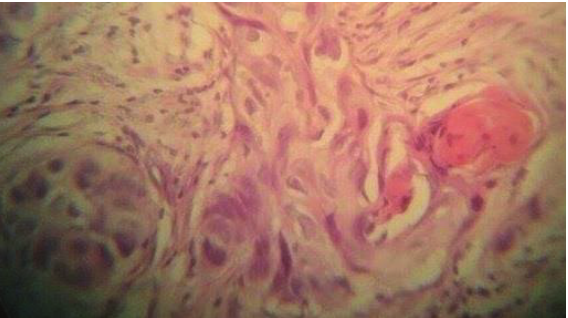
Figure 5: Histological view of the breast mass showing typical structure squamous cell carcinoma (hematoxylin and eosin, ×